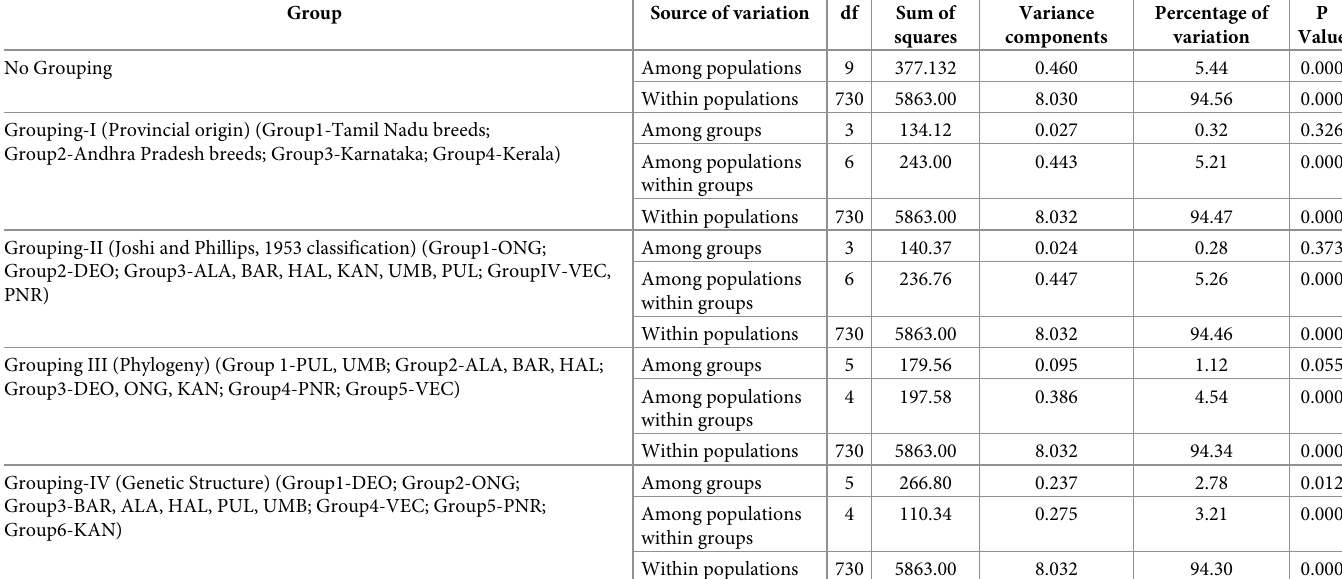
Table 3. Analysis of variance (AMOVA) among draught type zebu cattle from South India. Group